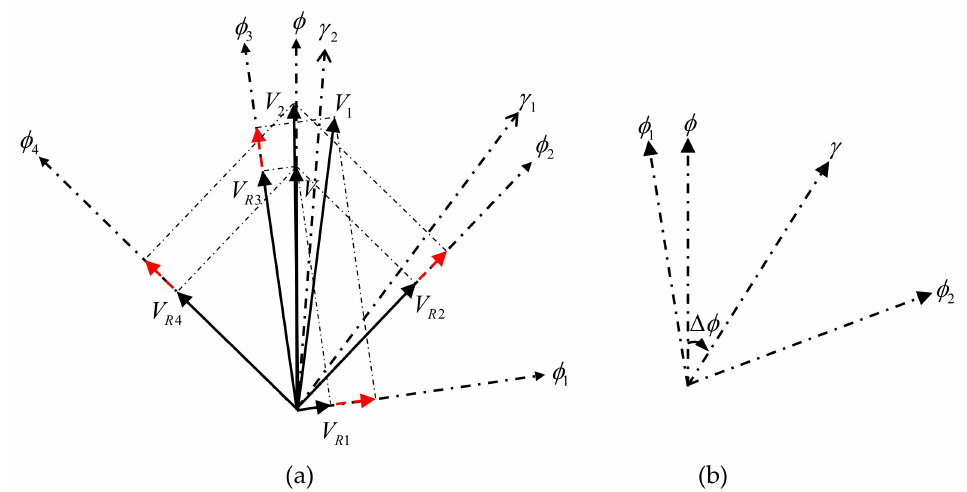
Figure 5. Schematic diagram of vector current velocity determination using different observation azimuths. ( a ) Illustration of vector current determination. ( b ) Illustration of ∆ φ